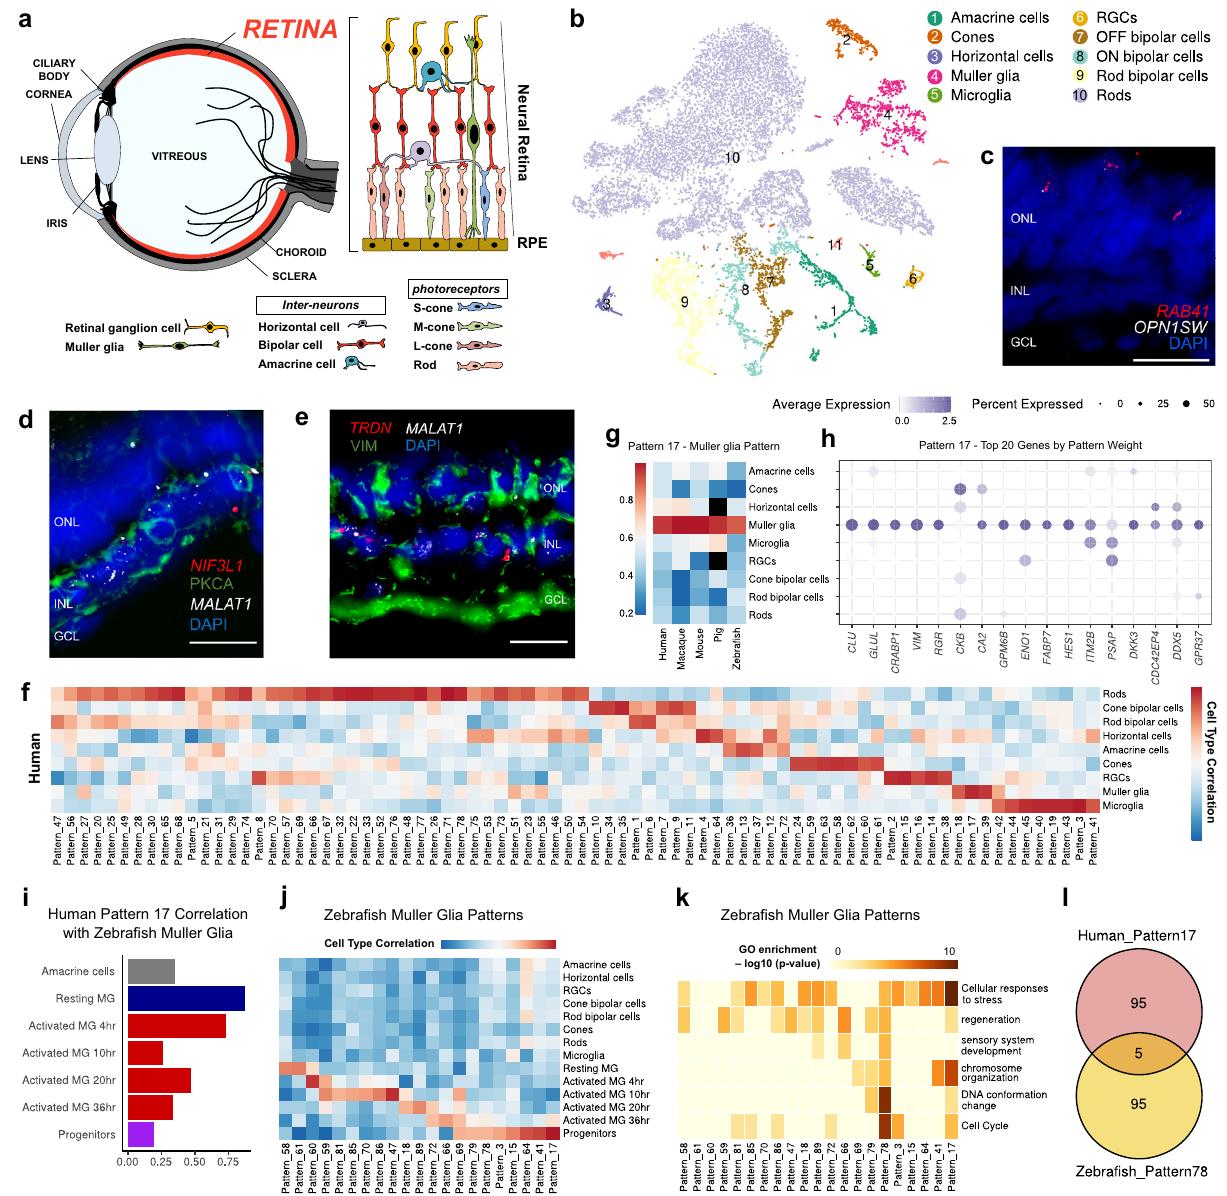
Fig. 2 Meta-analysis of retinal cells with different donors and species. a Highlighted region of the eye was selected for single-cell analyses. b tSNE plot visualisation of cells obtained from human retina. Ten transcriptionally distinct clusters were observed in the neural retina of the eye. c RAB41 colocalisation with OPN1SW using RNA FISH. INL inner nuclear layer, ONL outer nuclear layer, GCL ganglion cell layer. Scale bar = 20 µ m. n = 2 technical replicates. d , e Representative RNA FISH images of the novel markers TRDN ( e ) and NIF3L1 ( d ) for different regions of the eye. MALAT1 was used as an internal control, while PKCA was immuno-stained with NIF3L1 and TRDN with VIM . Scale bar = 20 µ m. n = 2 technical replicates. f Patterns of gene expression as determined by scCoGAPS algorithm in retinal cell types of the human eye (see Supplementary Information). The correlation of each pattern to human retinal cell types was colour-coded. g Pattern 17 showed a high correlation to Muller glial cells across species. h Bubble plot showing expression levels of the top 20 genes by gene weight of pattern 17. The size of each circle is proportional to the percentage of cells expressing the gene, and its intensity depicts the average transcript count within expressing cells. i Correlation of human pattern 17 with resting Muller glial cells and Muller glial cells activated after injury in zebra fi sh. j The patterns of gene expression in zebra fi sh Muller glial cells which were activated after injury. k Respective GO of the patterns in Fig. 2j. Metascape calculated the statistical signi fi cance of each GO term enrichment ( p -value) based on the accumulative hypergeometric distribution. The grey colour indicated a lack of signi fi cance. l List of genes that were common between human pattern 17 and zebra fi sh pattern